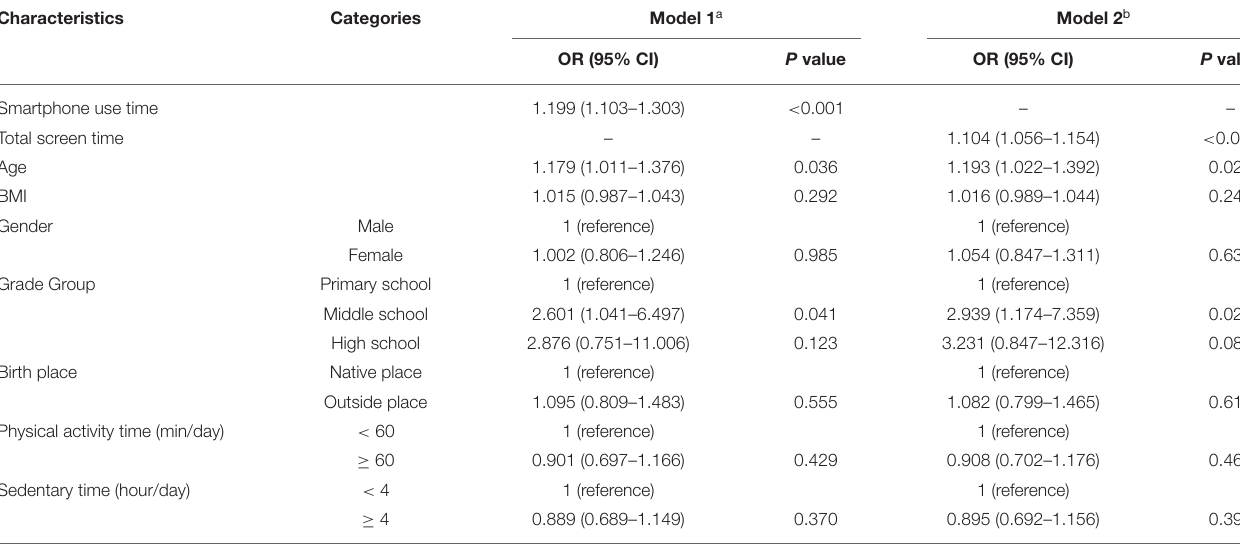
TABLE 3 | Associations between smartphone use time or total screen time and abnormal academic stress by multivariable logistic regression.